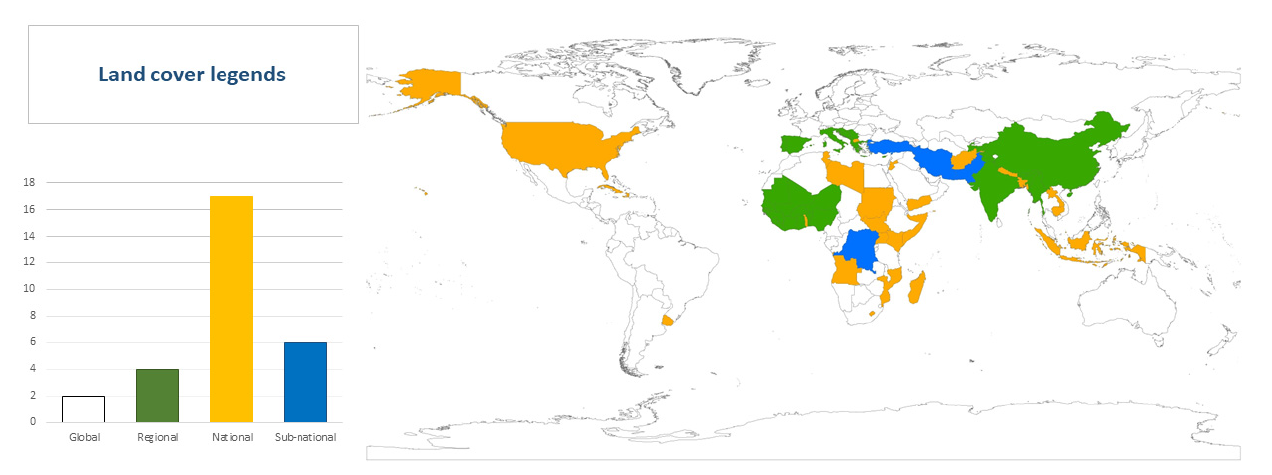
Figure 6. Status of land cover legends in the land cover legend registry platform using the LCCS3 tool.